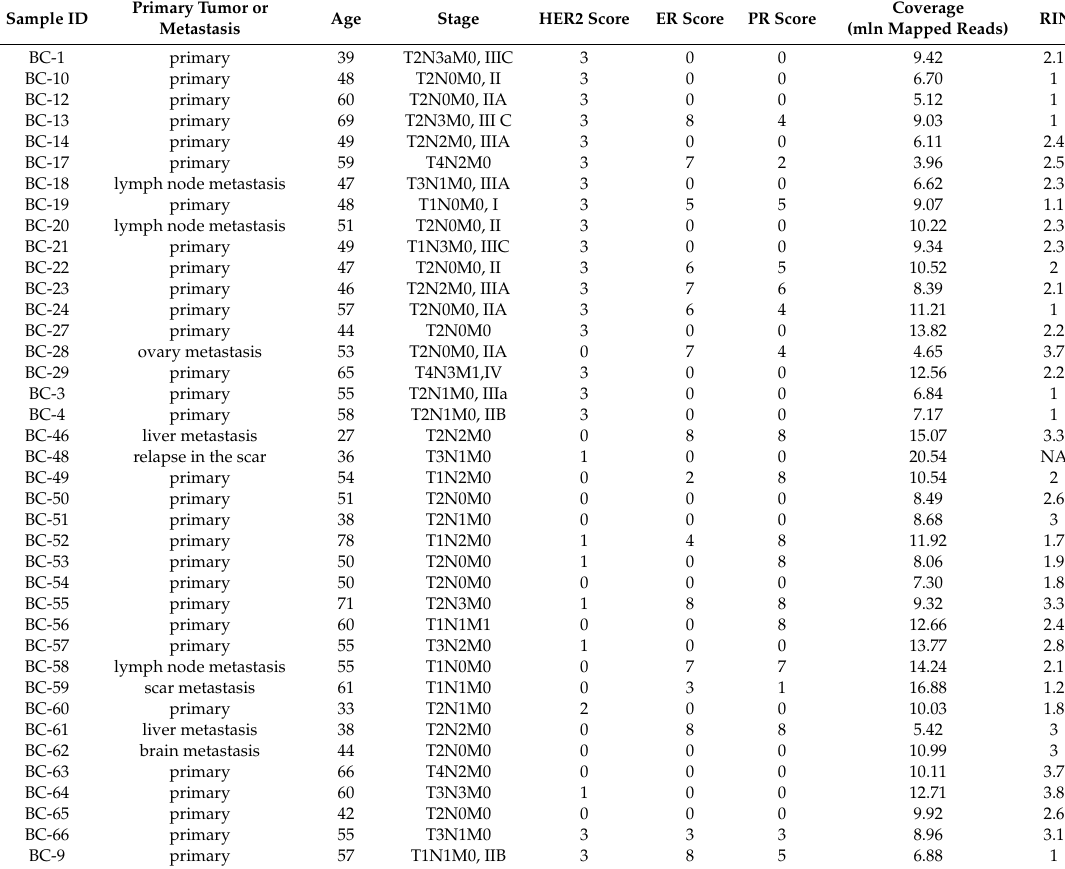
Table 1. Clinical and molecular annotation of the breast cancer